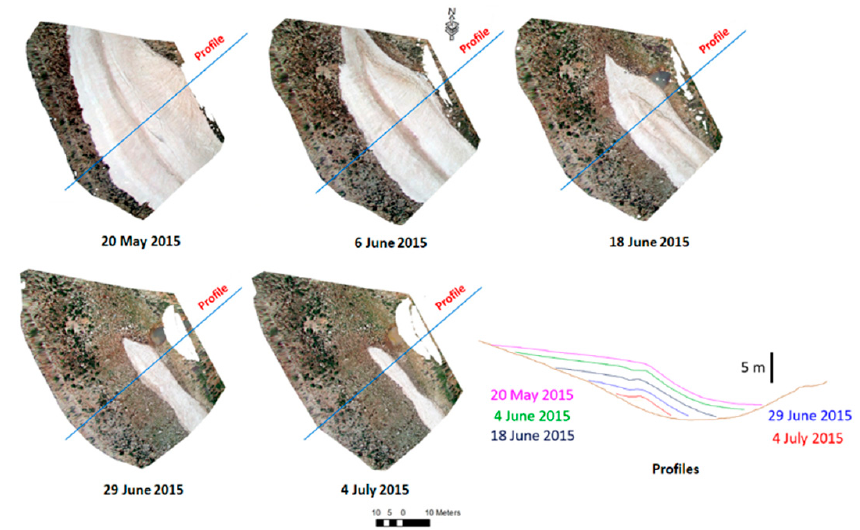
Figure 4. Profiles of the snow surface extracted from the DEM produced from the total station data.